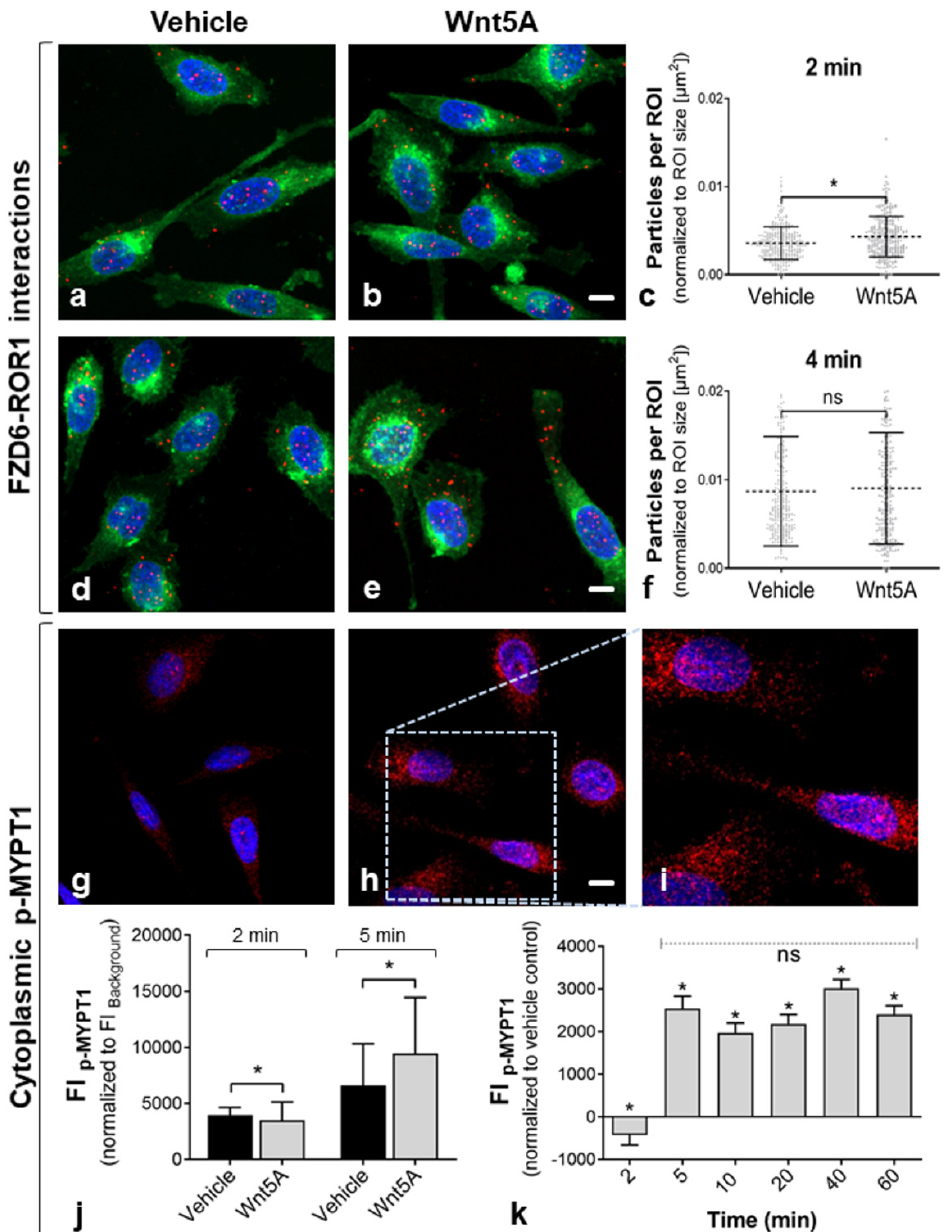
Figure 4. Wnt5A-dependent activation of the non-canonical Wnt/PCP pathway by Wnt5A following short-term co-localization of FZD6–ROR1. Co-localization of FZD6 and ROR1 by Wnt5A treatment and subsequent detection of cytoplasmatic p-MYPT1 suggests a rapid receptor interaction and early Wnt/PCP signaling in PC-3. ( a – h ) FZD6–ROR1 interaction complexes in PC-3 cells after 2 and 4 min of Wnt5A incubation ( b , e ) versus vehicle-treated controls ( a , d ). FZD6–ROR1 complexes (red); plasma membranes (green); nuclei (blue). Scale bar: 10 µ m. ( c , f ) Quantification of PLA signal densities by particle analyses at the single-cell level. Particles were normalized to the area of cells (ROIs). The amounts of FZD6–ROR1 complexes was higher after 2 min ( n = 306 vs. n = 304 cells) of incubation with Wnt5A, while there was no difference after 4 min ( n = 264 vs. n = 263 cells, vehicle vs. Wnt5A; * p ≤ 0.05, Mann–Whitney Test); mean + SD; n = 3 independent experiments. ( g – k ) Increase of p-MYPT1 (Thr696) in the cytoplasm. ( g – i ) Immunofluorescence images of p-MYPT1 staining. ( g ) Low levels of p-MYPT1 in control cells; ( h , i ) increased levels of p-MYPT1 after incubation of PC-3 cells for 5 min with Wnt5A. p-MYPT1 (red); nuclei (blue). Scale bar: 10 µ m. ( j , k ) Quantification of p-MYPT1 (FI, fluorescence intensity) in the cytoplasm. Significantly increased cellular p-MYPT1 was detected after 5 min and up to 60 min of Wnt5A incubation; * significance vs. vehicle-treated control (* p ≤ 0.05, Mann–Whitney Test); ( k ) cellular p-MYPT1 levels (normalized to vehicle-treated control) remained constant until 60 min of Wnt5A treatment. (ns = not significant, p ≤ 0.05, one-way ANOVA, post hoc test for linear trend, R 2 = 0.109); mean + SD; n = 3 independent